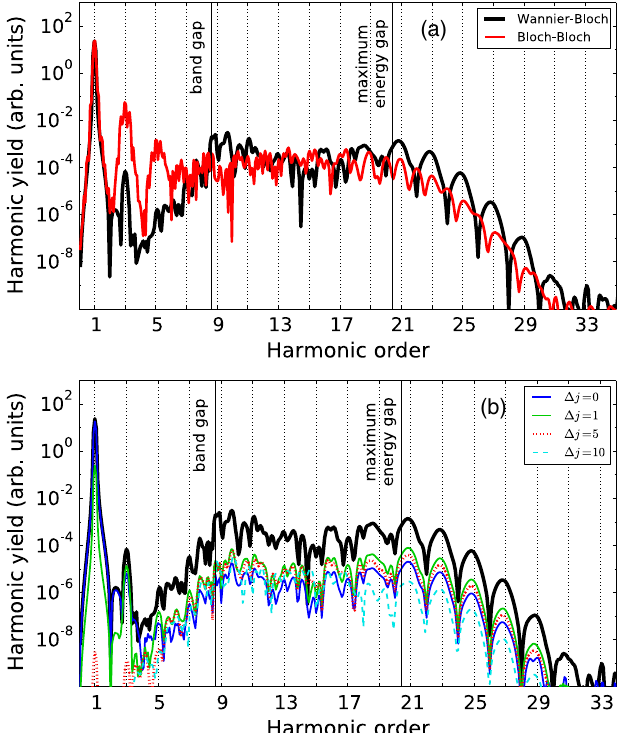
FIG. 2. Harmonic spectra comparison of the Wannier-Bloch approach (black line) with the Bloch-Bloch approach (red line) is shown in panel (a). Decomposition of the harmonic contribution into different lengths of electron-recombination atomic sites Δ j using the Wannier-Bloch method is depicted in panel (b). The calculations are carried out for laser polarization in the Γ − M direction of ZnO crystal. The laser parameters are as follows: carrier wavelength of λ 0 ¼ 3 . 25 μ m, laser intensity I 0 ¼ 3 . 15 × 10 11 W = cm 2 , total number of laser cycles N ¼ 10 0 periods, and φ CEP ¼